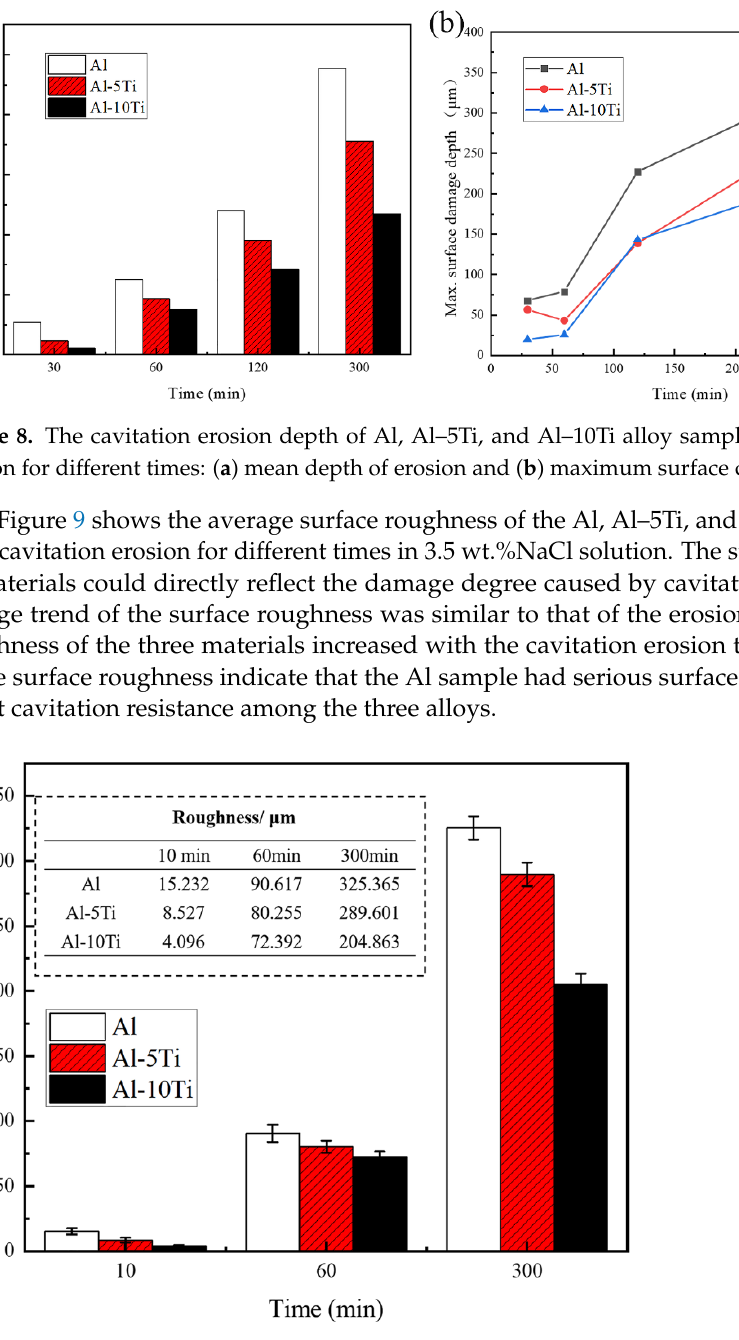
Figure 9. Average surface roughness of Al, Al–5Ti, and Al–10Ti samples after cavitation erosion for different times in 3.5 wt.% NaCl solution.